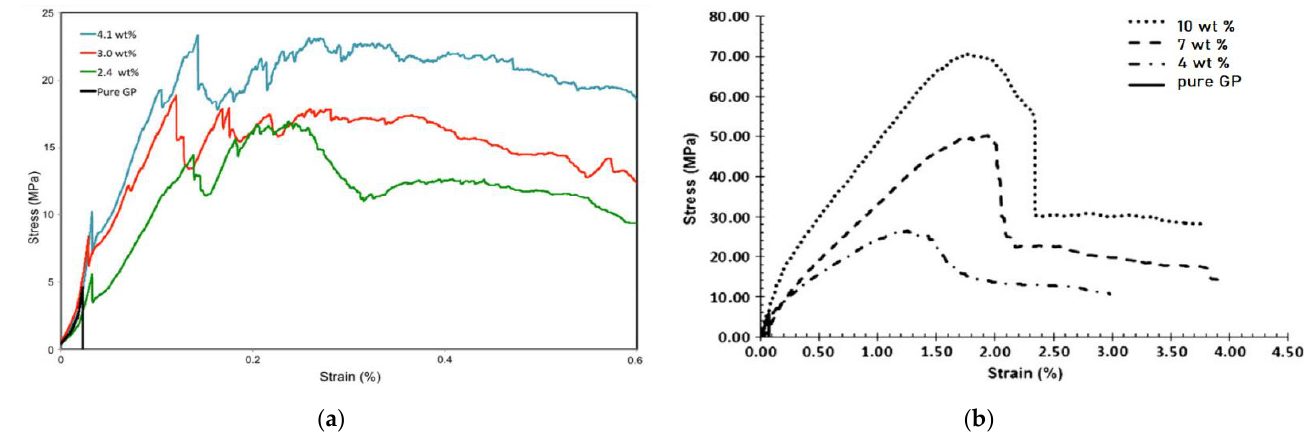
Figure 12. Typical stress–strain curves of pure geopolymer and PFRGs with various fiber contents ( a ) Flax fibers: 0–4.1 wt% [97], ( b ) phormium tenax fibers: 0–10 wt% [116].